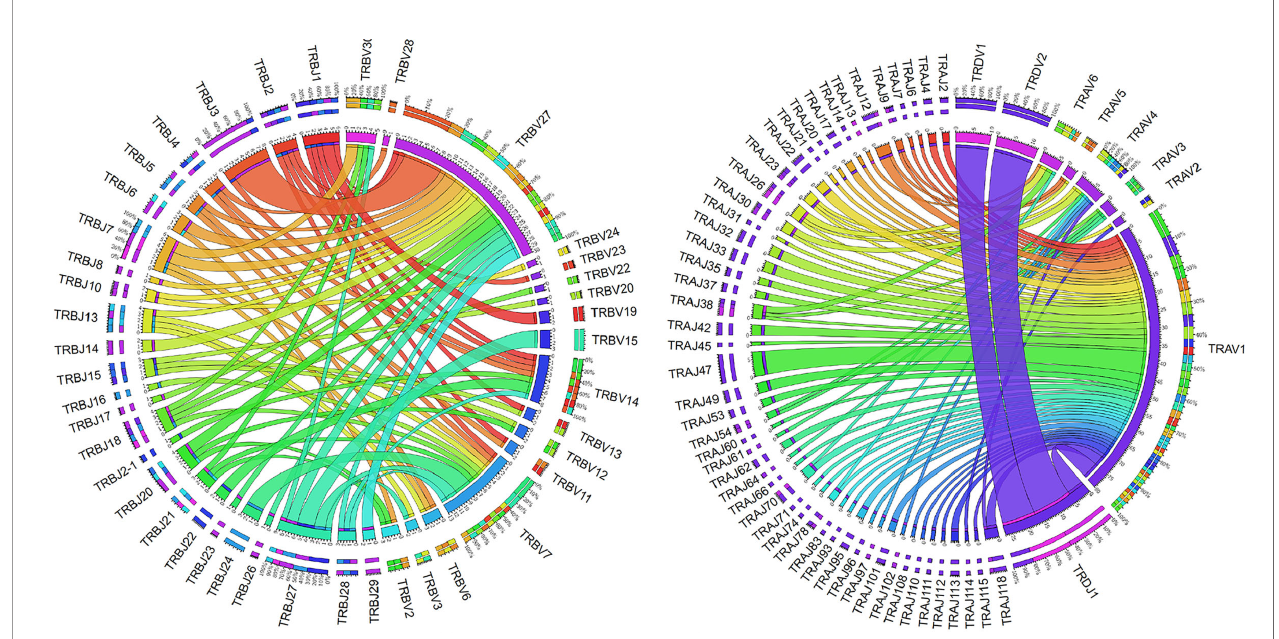
FIGURE 7 | Cat fi sh TRB and TRAD clonotype analysis. The TRB and TRAD clonotypes were mapped by V gene subgroup to their associated J gene. Chord diagrams were drawn using Circos based resolved parings of speci fi c V gene subgroups and single J genes from TRA/D (n = 122) and TRB (n = 83) clonotypes. Labels along the edge of the inner circle provide the number of associations between any given TRJ gene and TRV subgroup pair. Tick marks represent values of 0.5 (clonotypes numbers represent integers only). Ribbons are colored according to the J gene (row in the table); and segment color interpolation was performed according to count. Outer labels of the chord diagrams indicate the relative percentages of total counts for each segment and are listed from largest to